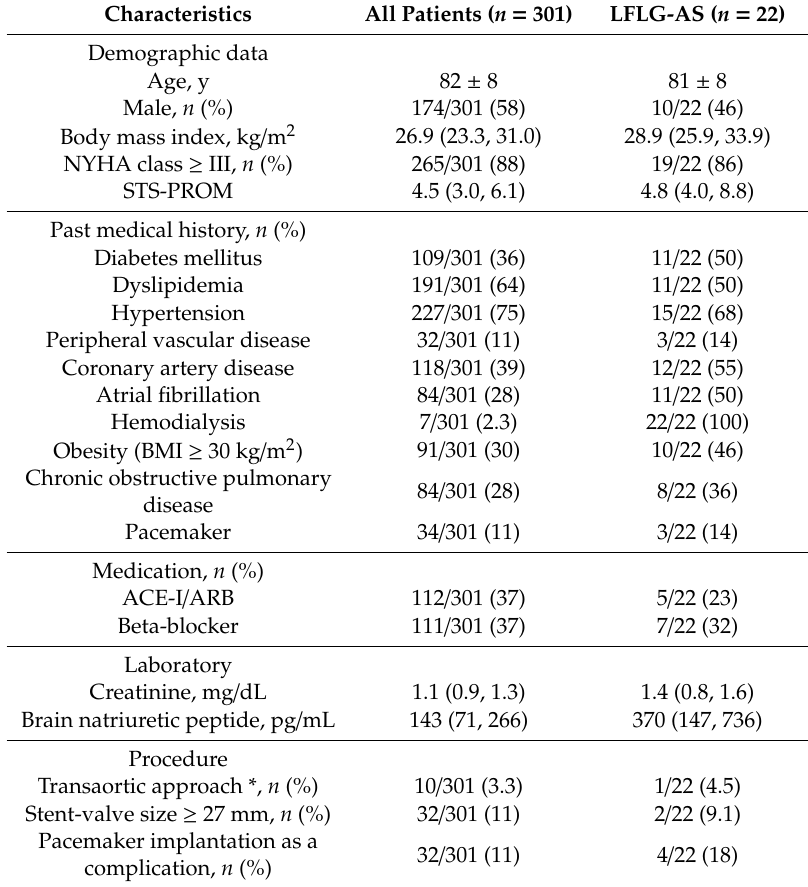
Table 1. Baseline characteristics and